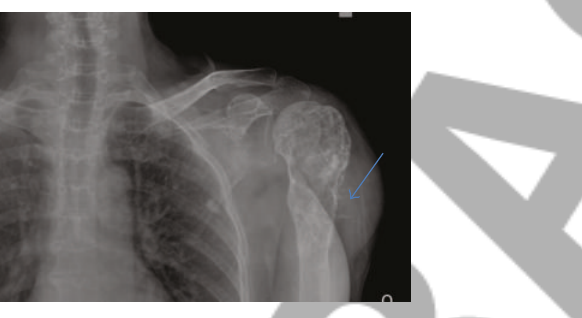
Figure 2: A 60-year-old female came with the c/o pain and swelling in upper arm. Radiograph of left shoulder shows lobulated, and expansile, osteolytic lesion involving the head, neck and proximal shaft of humerus including medullary and cortical region. Few specks of calcification were seen. With involvement of soft tissue.